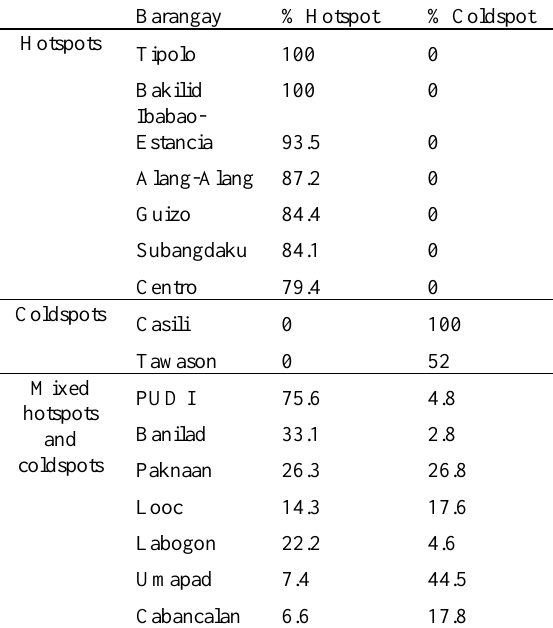
Table 2. Percentage of hotspot and coldspot pixels